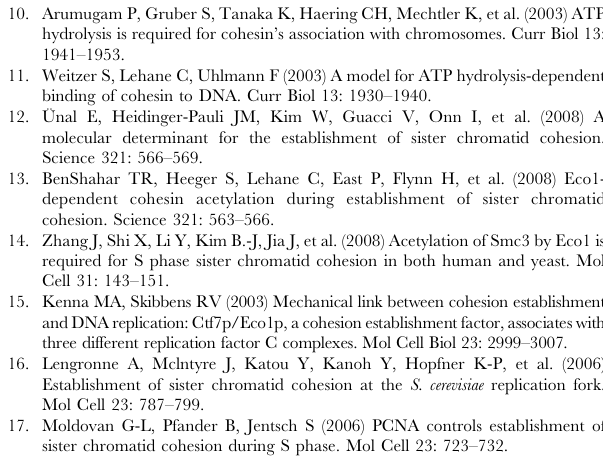
plant growth. (A-D) Seedling phenotypes of 21-day-old wild-type (Col-0) (A), etg1-2 (Col-0 background) (B), ctf18-2 (Col-0 background) (C), and etg1-2 ctf18-2 (D) plants. (E-I) Seedlings phenotype of 21-day-old wild-type (Col-0) (E), etg1-2 (Col-0 (H), and etg1-2 ctf18-1 (I) plants. Figure S5 Genetic interaction between etg1 and cohesin mutant syn4 . (A-D) Seedling phenotypes of 21-day-old wild-type (Col-0) (A), etg1-2 (Col-0 background) (B), syn4 (Col-0 background) (C), and etg1-2 syn4 (D) plants. (E-G) Leaf growth of the first leaf pair of 21-day-old wild-type (Col-0), etg1-1, syn4 , and etg1-1 syn4 plants. Leaf blade area (E), epidermal cell size on the abaxial side of the leaf (F), and epidermal cell number on the abaxial side of the leaf (G). Data represent average 6 SD (n= 5). Table S1 Upregulated genes in etg1 compared with the wild-type genes (Col-0). Table S2 Downregulated genes in etg1 compared with the wild- type genes